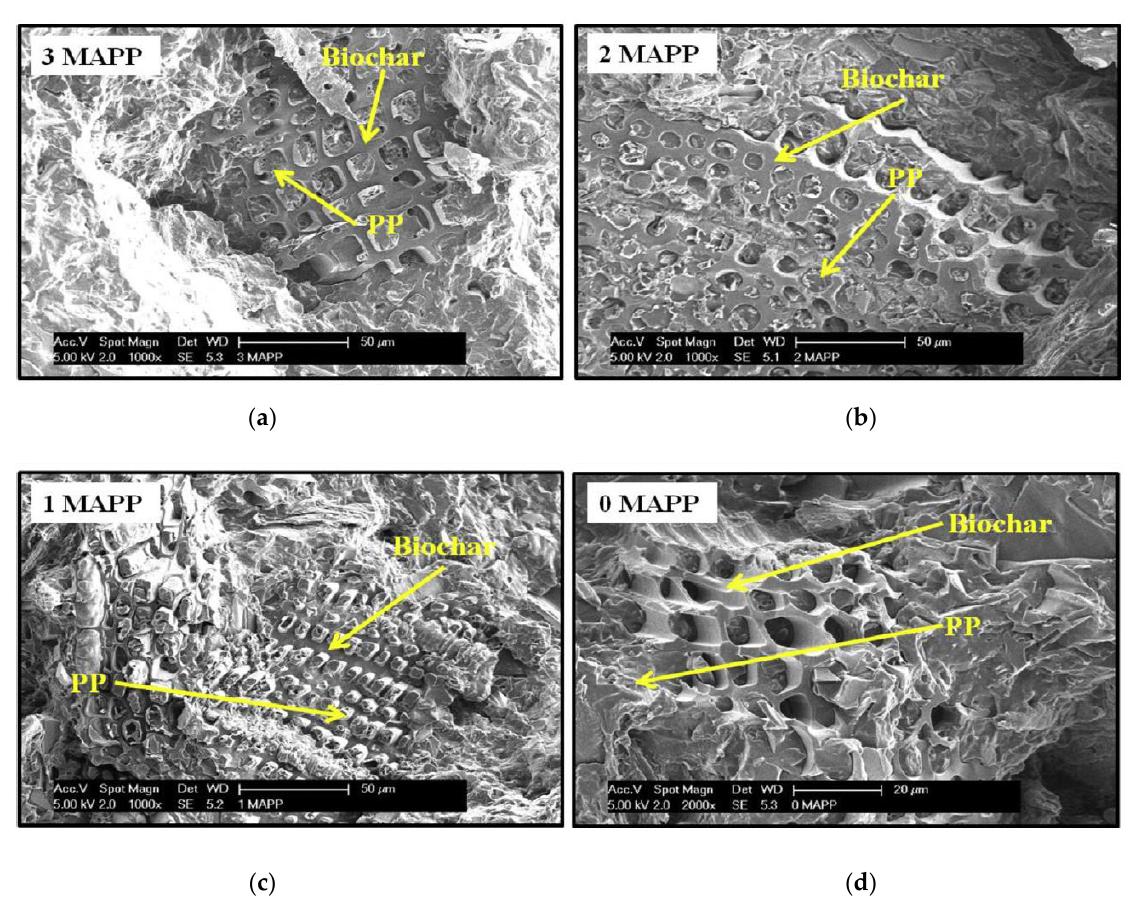
Figure 9. The SEM images of fractured surfaces of biochar filled polypropylene composites (a) 3 MAPP (b) 2 MAPP (c) 1 MAPP (d) 0 MAPP, the images show mechanical interlocking between the filler and the matrix polymer even at 1% concentration of compatibilizer attributed to its excellent mechanical properties. Figure taken from [40] with permission to use from Elsevier Publications 2016.